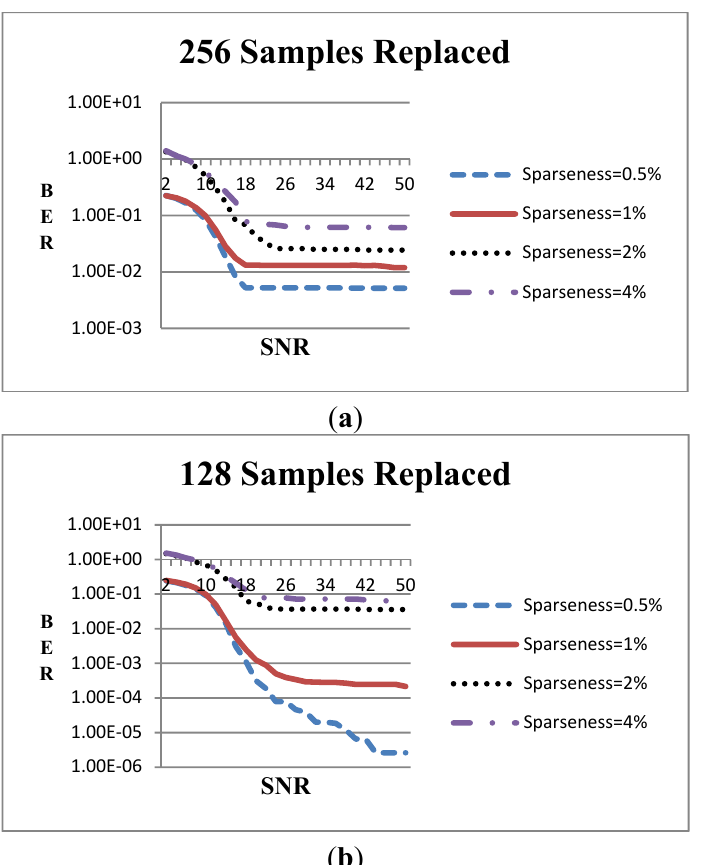
Figure 6. BER vs. SNR when Viterbi decoder is used and the number substituted samples is ( a ) 256, ( b ) 128, ( c ) 86 and ( d )